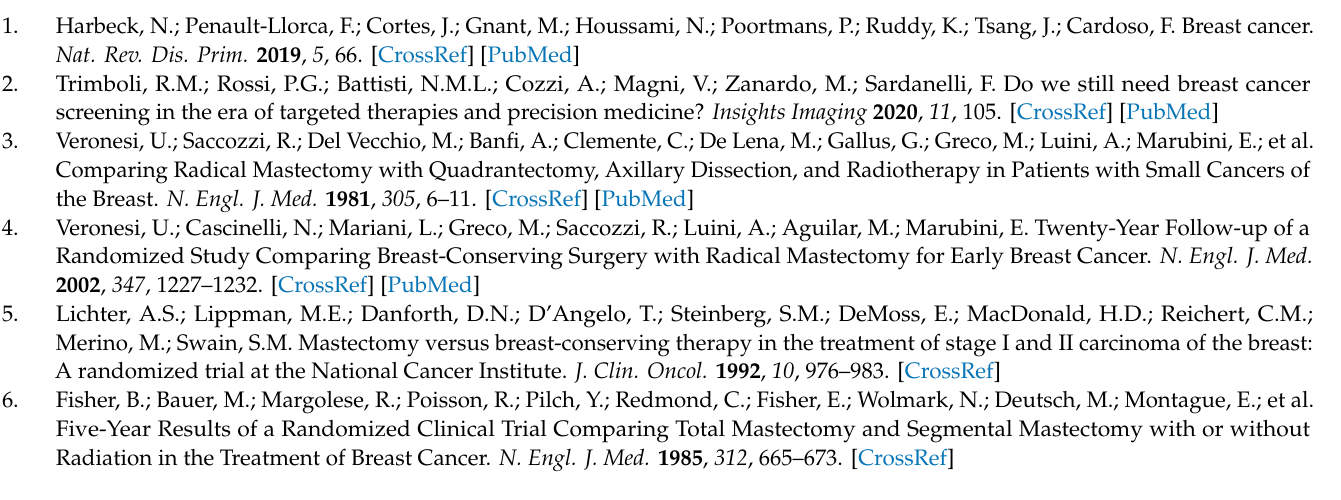
Table S2: Comparison of the segmentation times obtained by applying both manual segmentation and region-growing segmentation to the subset of 32 patients with 32 unifocal lesions; Figure S1: Bland– Altman plot for the interobserver reproducibility of the region-growing segmentation of tumour volume; Figure S2: Bland–Altman plot for the interobserver reproducibility of the tumour-to-breast volume ratio obtained by the region-growing segmentation of the tumour